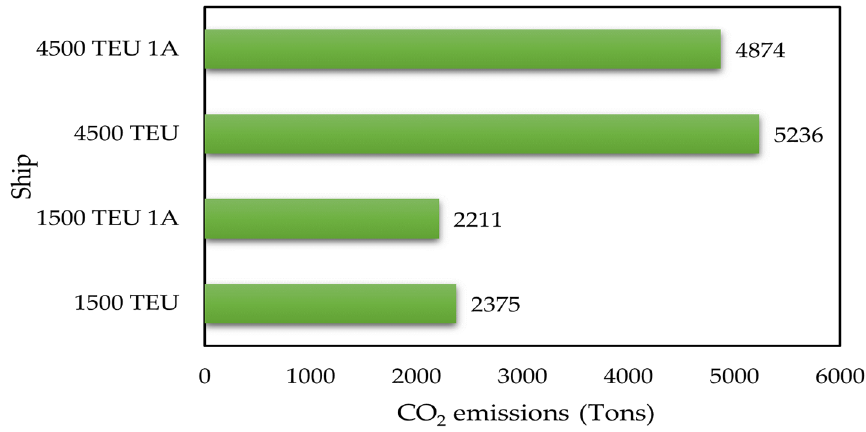
Figure 5. Comparison of CO 2 emissions for Americas sea route and Northwest Passage.